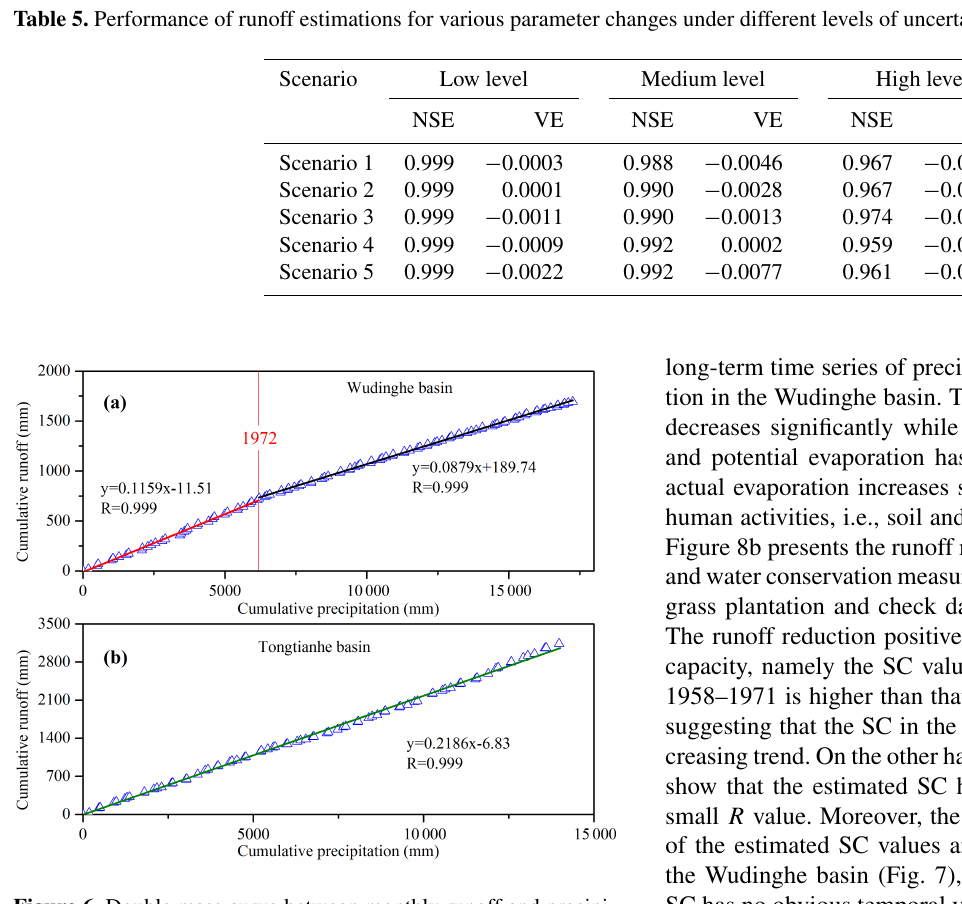
Figure 6. Double mass curve between monthly runoff and precipi- tation for Wudinghe basin within the period of 1958–2000 (a) and Tongtianhe basin within the period of 1982–2013 (b)